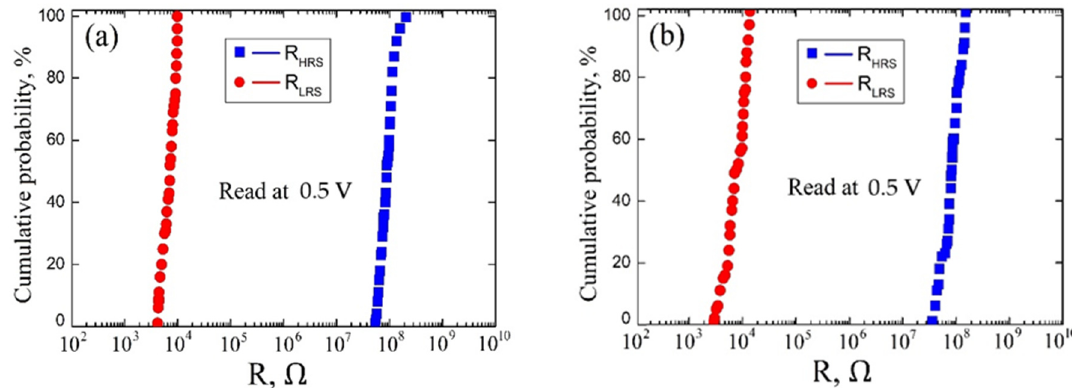
Figure 7. Cumulative probability data for the resistances of R HRS and R LRS for vanadium oxide films with 22.3 ± 4.4 nm film thickness: ( a )—uniformity test; ( b )—homogeneity test.